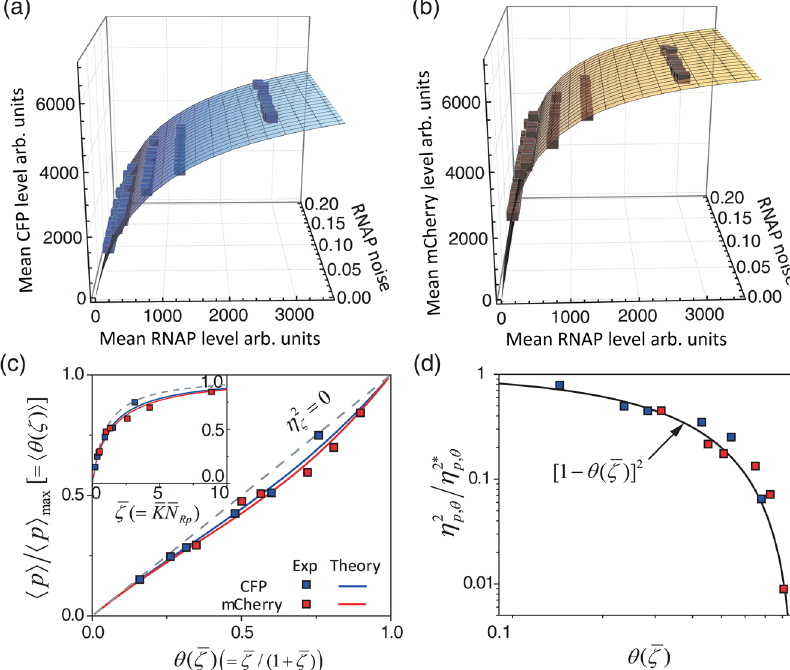
FIG. 4. (a),(b) The best global fit of Eq. (7) to the experimental data for the dependence of the mean protein level on the mean RNAP level and RNAP noise. See Eq. (I2) for the explicit expression of Eq. (7) in terms of the control variables in the experiment. (c) Dependence of the mean protein level scaled by its maximum or the mean RNAP occupancy of promoter, h p i = h p i ½¼ h θ ð ζ Þi(cid:2) , on max θ ð ¯ ζ Þ . Inset: Dependence of h θ ð ζ Þi on ¯ ζ (see Fig. 9 of Supplemental Material [32]). h θ i ¼ θ ð ¯ ζ Þ for η 2 0 (dashed line). η 2 0 . 44 and ζ ¼ ζ ¼ ¯ ζ scaled by its maximum η 2 ∗ on θ ð 0.59 for CFP and mCherry (Table I). (d) Dependence of η 2 Þ . For both CFP and mCherry, p; θ p; θ η 2 ≅ ½ 1 − θ ð ¯ ζ Þ(cid:2) 2 . Data for η 2 = η 2 (cid:4) are obtained from experimental data for η 2 by η 2 ¼ η 2 p − ½ð η int p Þ 2 þ η 2 (cid:2) , with ð η int p Þ 2 given by p p; θ p; θ p; θ p; θ p;k Eq. (F1) and η 2 given in Table I. The value of the RNAP noise η 2 in (c) and (d) is the same as in Figs. 3(d) and N Rp p;k